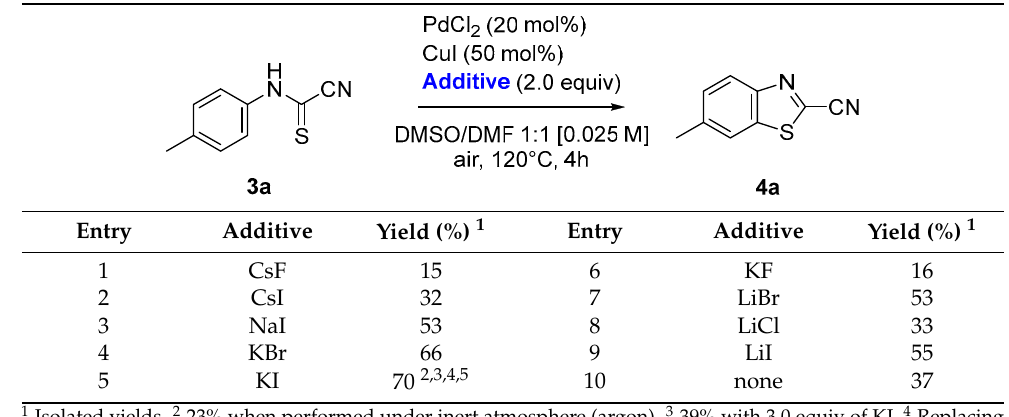
Table 2. Effect of inorganic additives and ambient atmosphere.